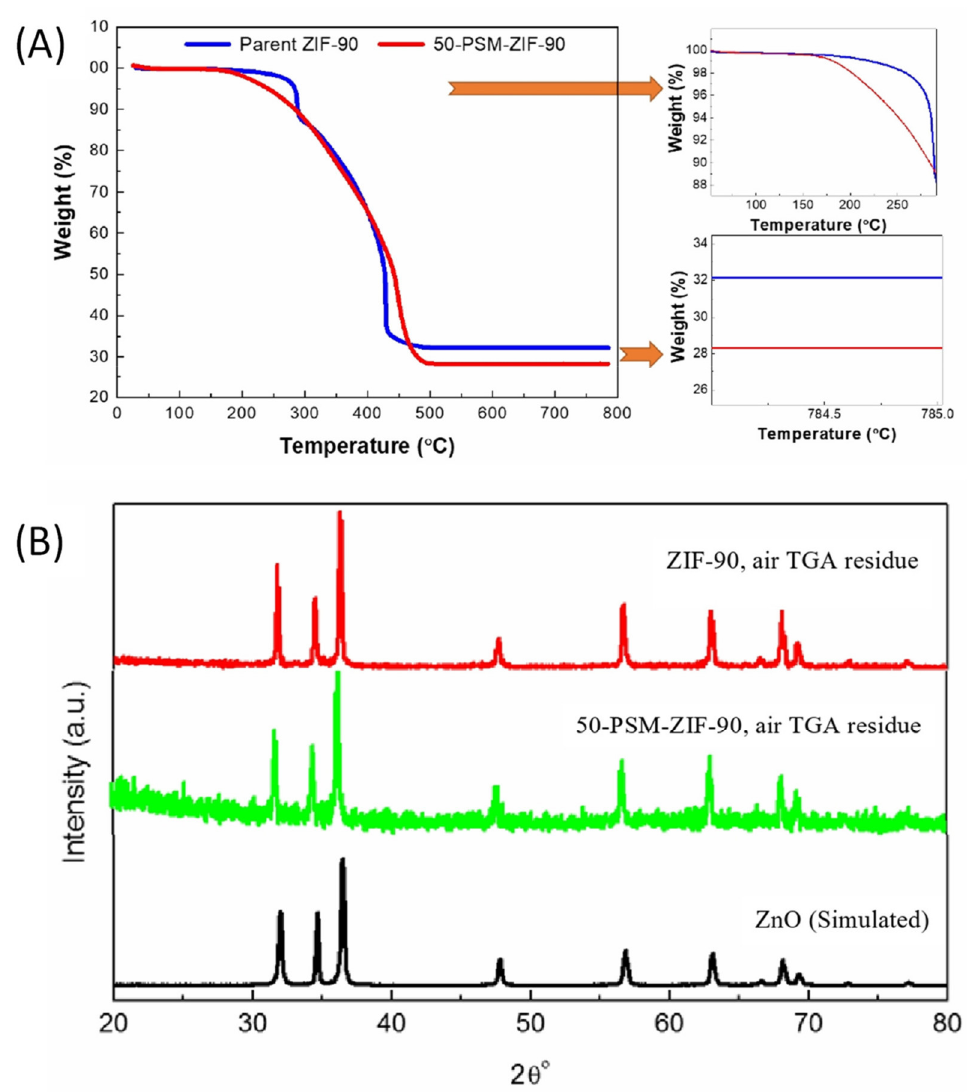
Figure 6. ( A ) TGA of the pure ZIF-90 and 50-PSM-ZIF-90 ( B ) PXRD analysis of TGA residue of ZIF-90, 50-PSM-ZIF-90 and simulated ZnO.